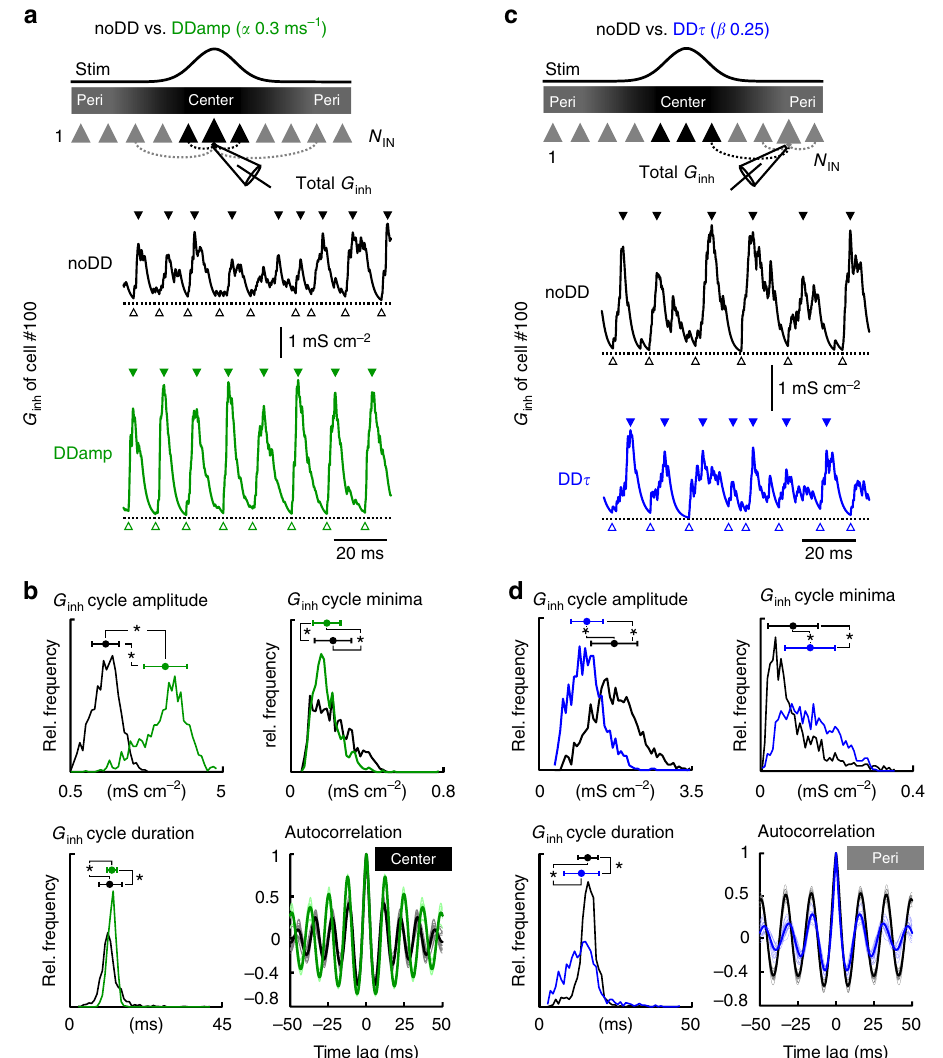
Fig. 6 Distance-dependence in the amplitude boosts synchrony of central inhibition and distance-dependence in the time course desynchronizes inhibition in the periphery of an IN network model. a Representative total inhibitory conductance ( G inh ) recorded from a cell (#100) exposed to focal stimulation (Stim) in the noDD (black trace) and the DD 0.3 | 0 (green trace) interneuron network model with distance-dependent amplitudes only (DDamp). Rhythmic patterns of G inh at gamma frequencies display peaks ( fi lled triangles) followed by troughs (open triangles) in an alternating manner. b Distributions of amplitude, minima (open triangles in a ) and duration of total G inh cycles. In the DD 0.3 | 0 network, mean amplitude of G inh is signi fi cantly larger ( p < 0.001, Mann – Whitney U- test) and duration less variable (SD) than in the noDD network ( p < 0.001, Ansari – Bradley test). Bottom right, the average autocorrelation of the G inh in central cells (#99-101) shows that periodicity of the G inh is higher in the DD 0.3 | 0 network. c In analogy to a , representative G inh recorded from a cell (#10) in the periphery of the noDD (black trace) and the DD 0 | 0.25 (blue trace) interneuron network model with distance-dependent time course only (DD τ ). d Distributions of amplitude, minima and duration of G inh cycles. In the periphery, G inh in the DD 0 | 0.25 circuit displays smaller cycle amplitudes (top left), higher residual inhibition at the troughs (top right) and a broader standard deviation of G inh cycle durations (bottom left). The weaker periodicity of the inhibition in the periphery of the DD 0 | 0.25 network is further con fi rmed by the auto-correlogram (bottom right, blue). Points with error bars represent mean and SD. Data in b , d are based on fi ve simulation